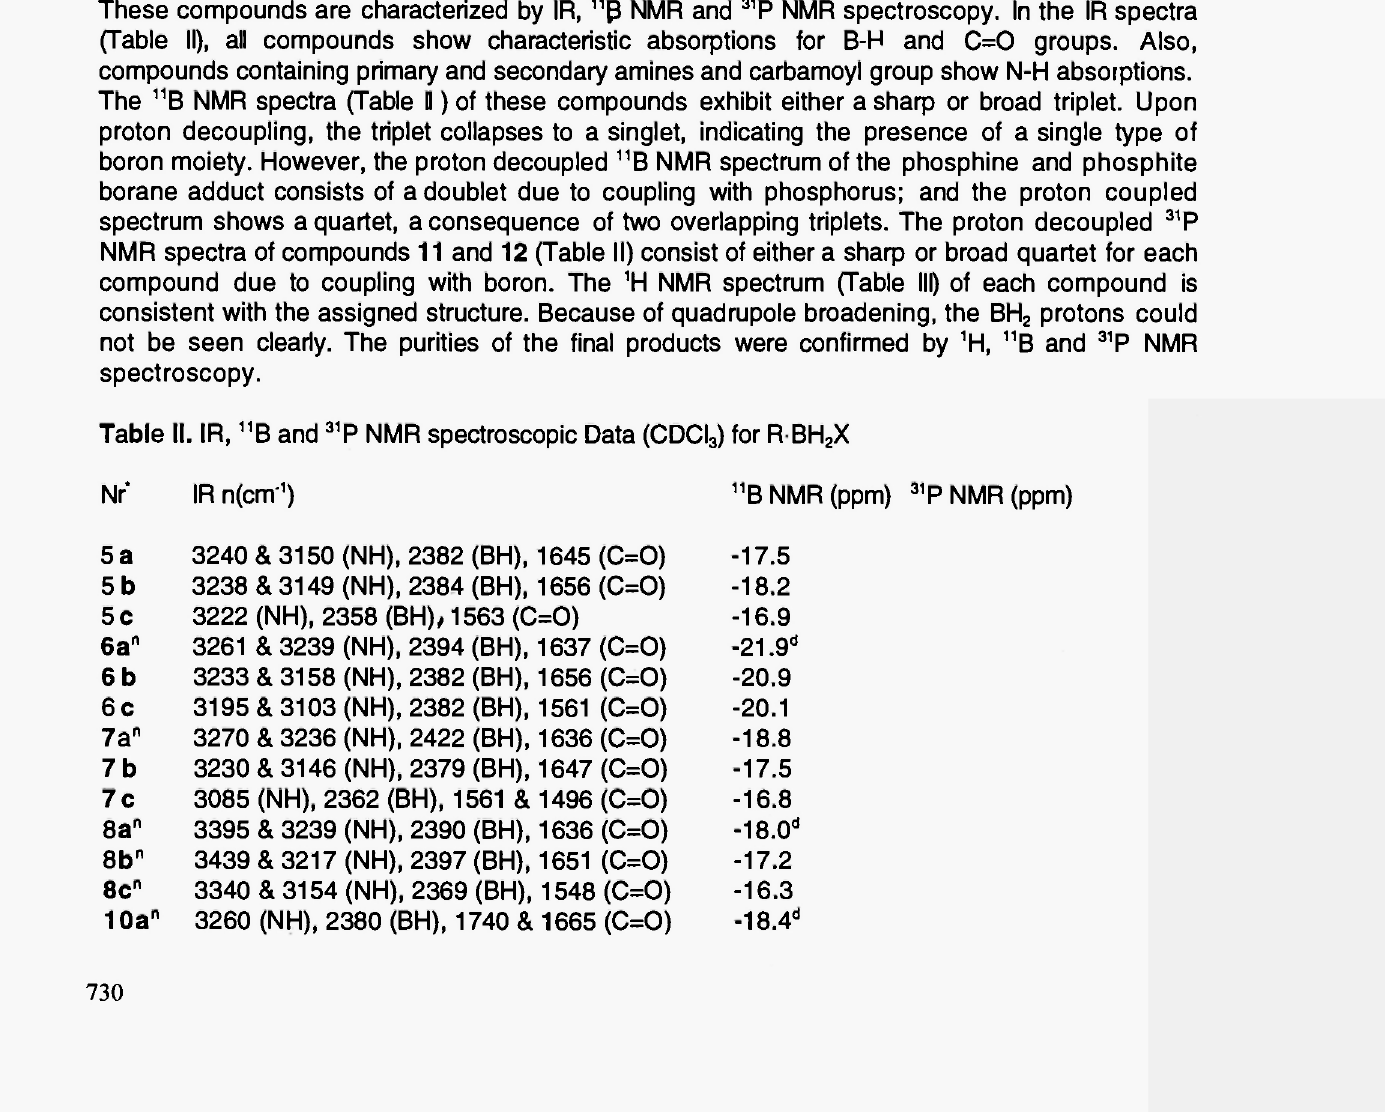
Table II. IR, 11 B and 31 P NMR spectroscopic Data (CDCI